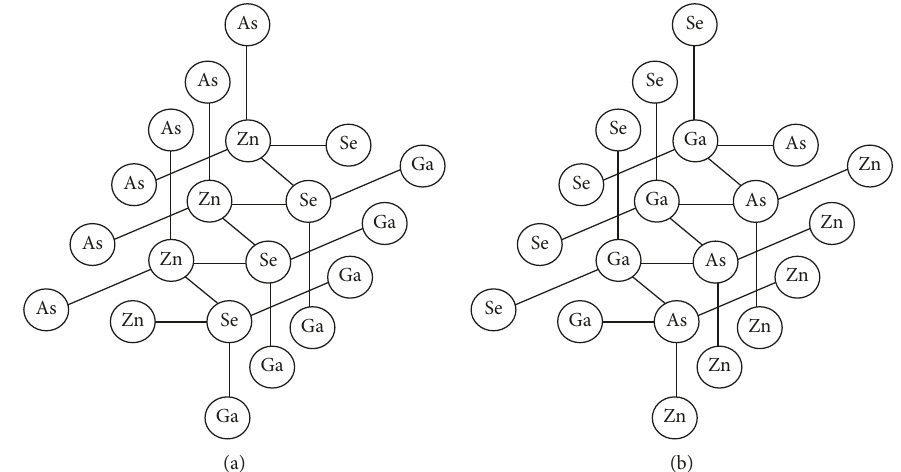
Figure 1: Tetrahedral bonds of the substitutional solid solution (GaAs) selenide (b).